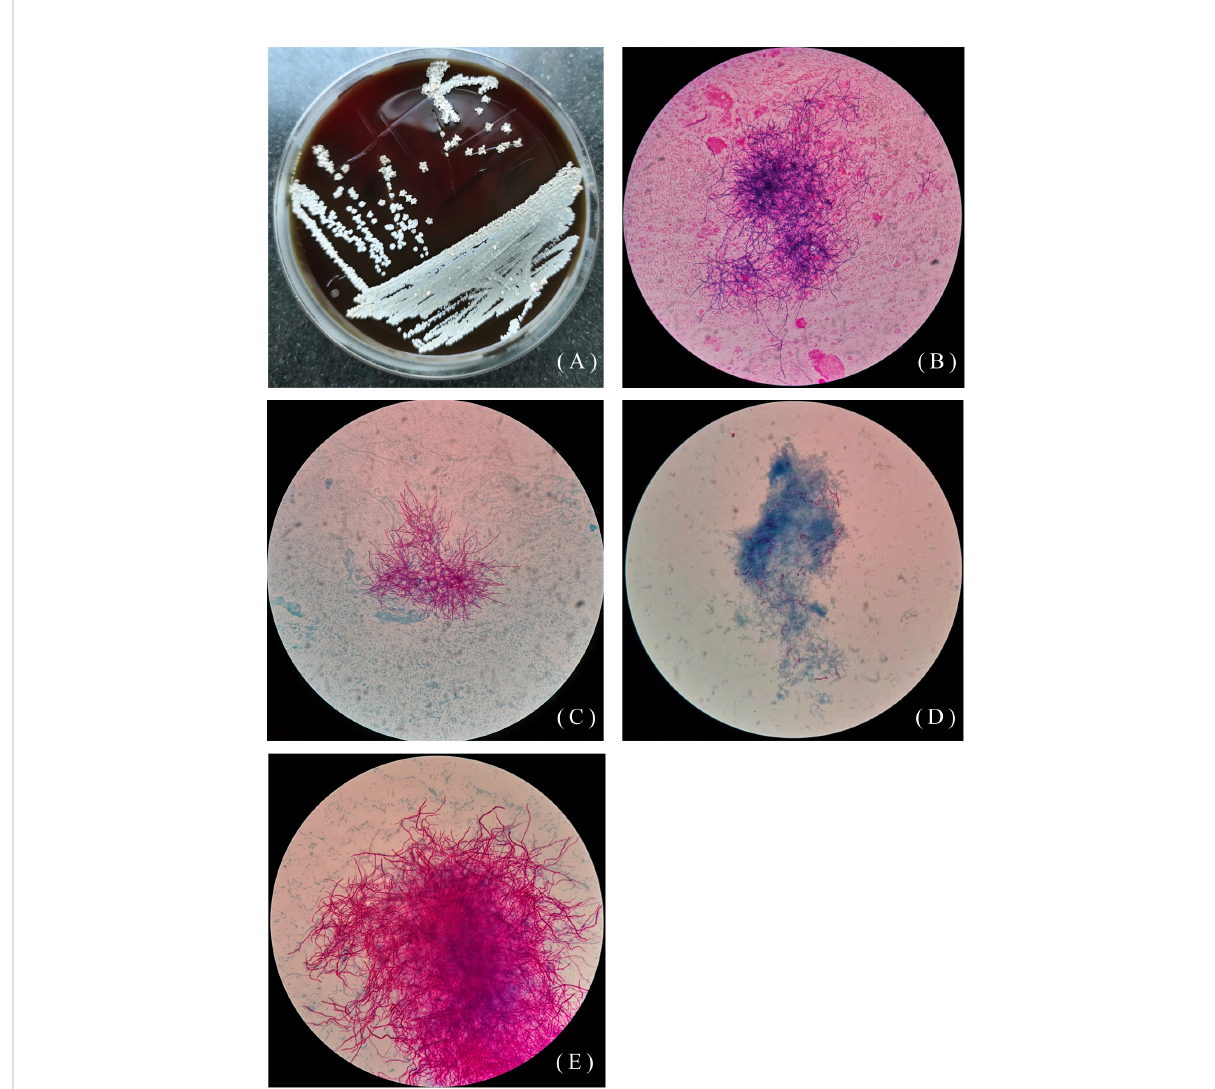
FIGURE 2 Colony morphology of isolate L5.54. (A) Colony morphology of L5.54 on blood agar plates. The colonies were white, rough and opaque, like a layer of hoarfrost on blood agar plates; (B) Gram staining of strain L5.54. After Gram staining of sputum specimens, it was observed that bacterial hyphae were stretched; (C) Acid-fast staining of sputum specimens of isolate L5.54. Acid-fast staining was weakly positive; (D) Acid- fast staining of strain L5.54 after blood plate cultured. Bacterial acid-fast staining was weakly positive, and the bacterial hyphae were very short; (E) Strain L5.54 cultured in 960 tuberculosis liquid medium. The strain L5.54 on the blood plate was cultured in 960 tuberculosis liquid medium, and the short bacteria reverted to long fi